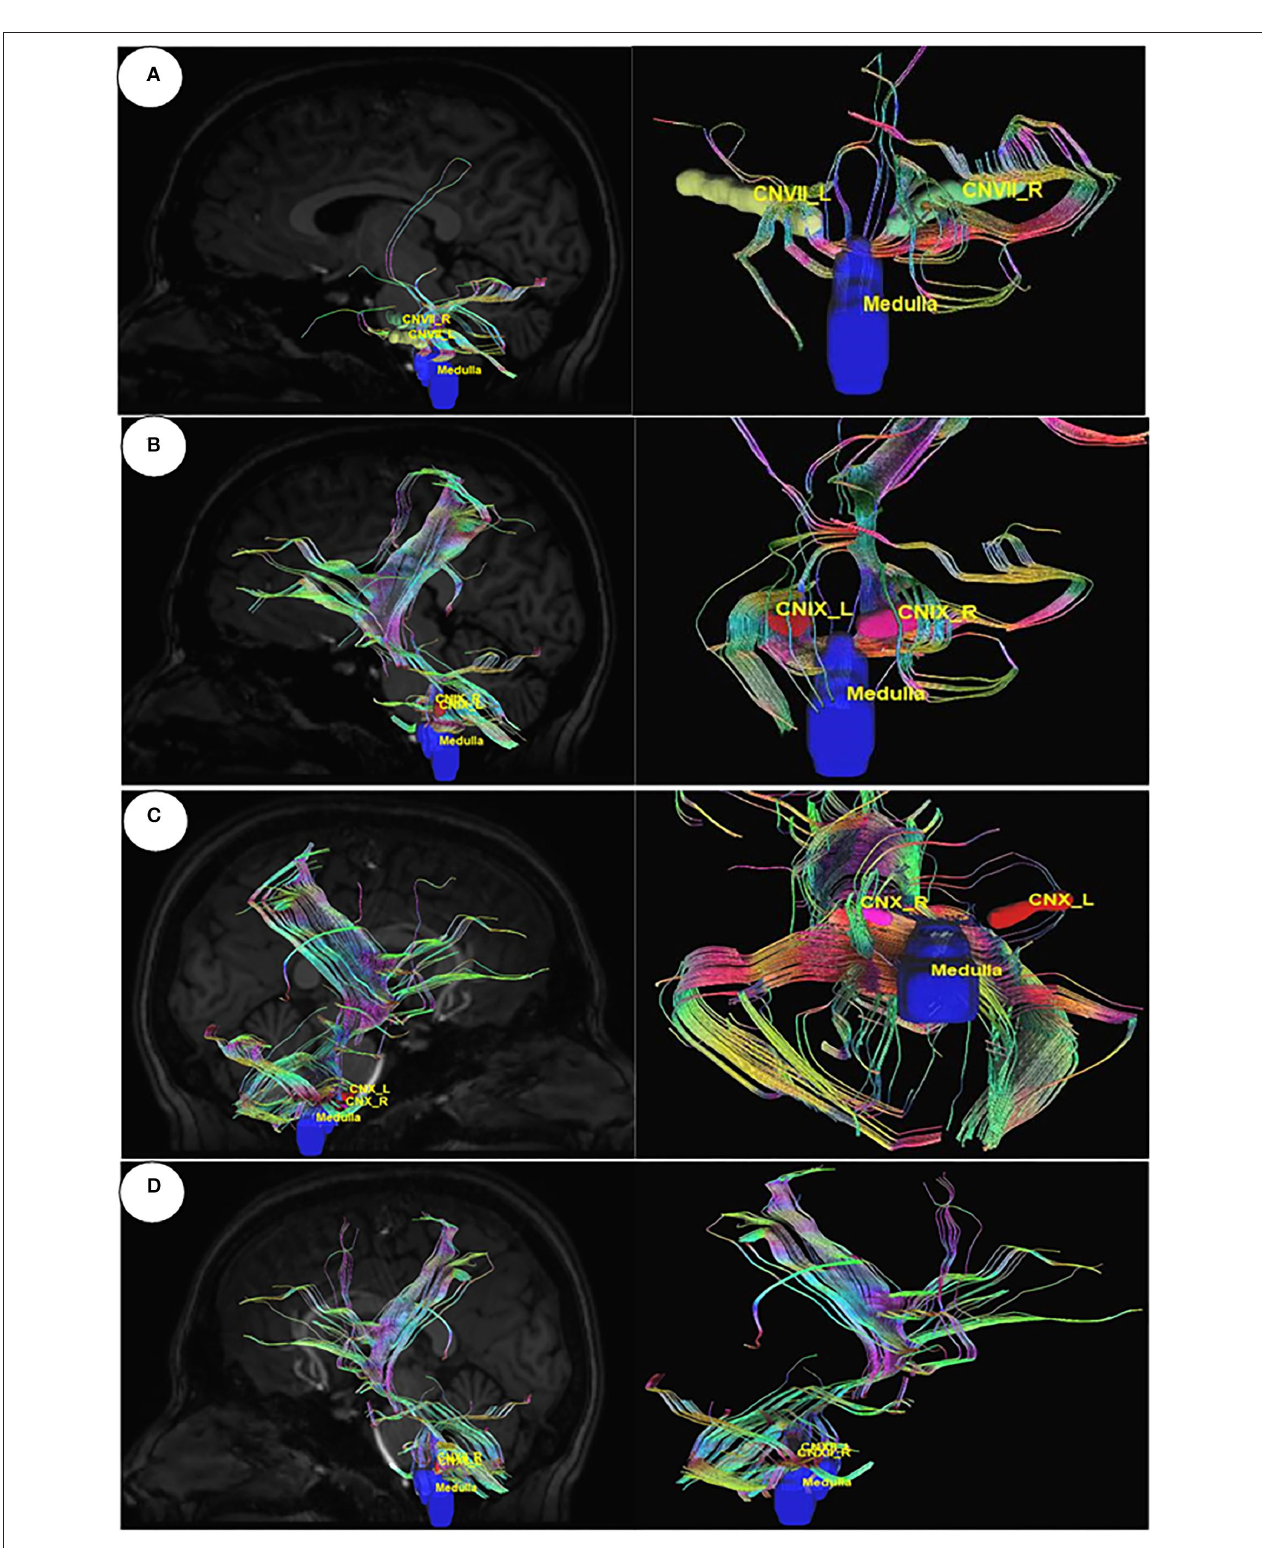
FIGURE 4 | Diffusion MRI fiber tracking connecting medulla oblongata with gustatory nerves. (A) medulla to cranial nerve VII, (B) medulla to cranial nerve IX, (C) medulla to cranial nerve X, and (D) medulla to cranial nerve XI.